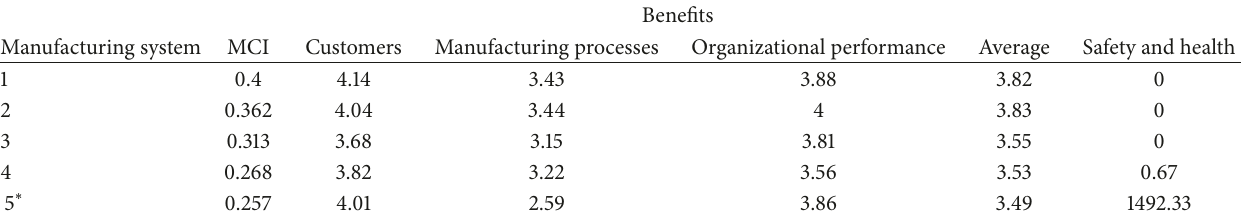
Table 5: Validation of the